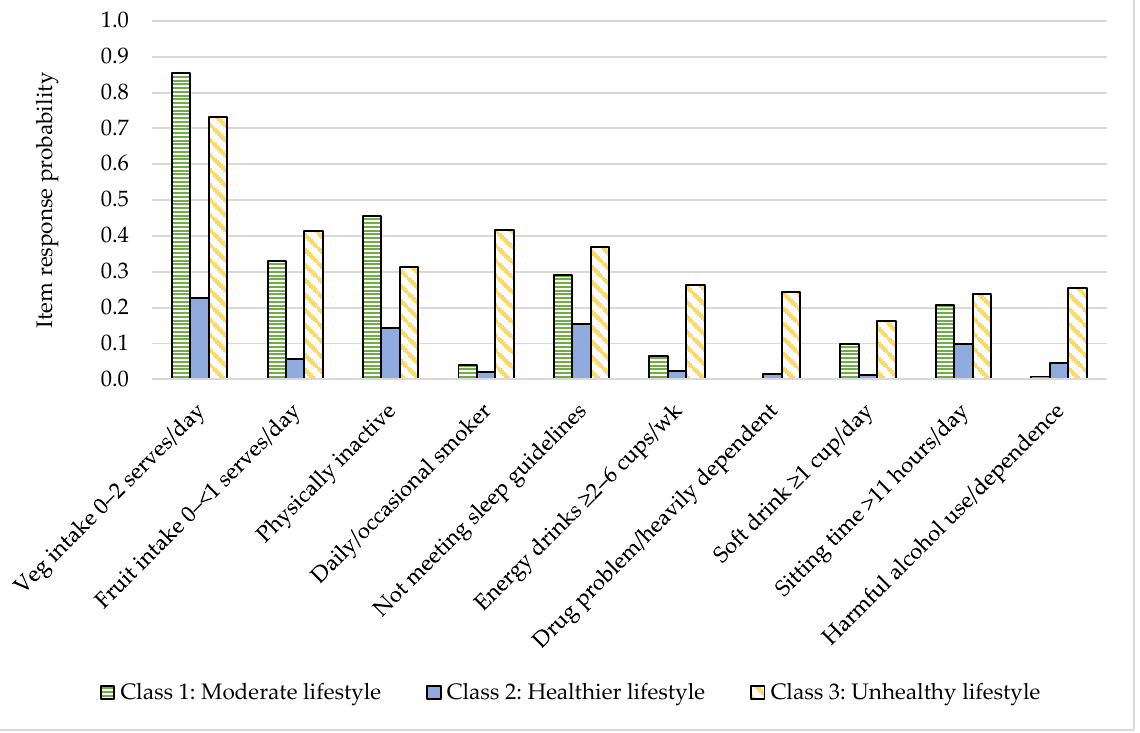
Figure 3. Item response probability for highest risk category of each health behavior by health behavior class.